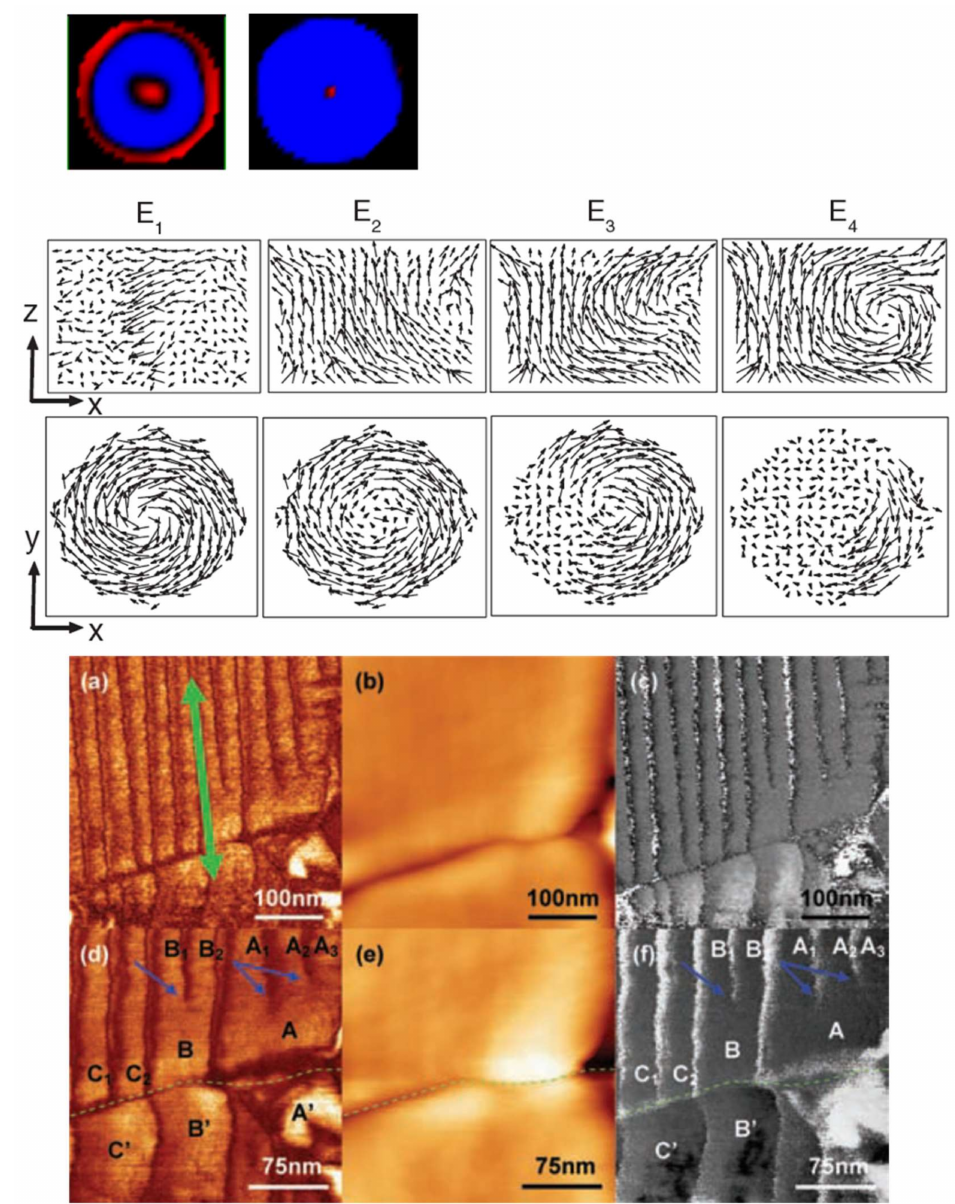
Figure 8. (Top) bull’s eye patterns in PZT [32]; (Center) spiral domains [39]; (Bottom) dislocation twinning instabilities visible in panels